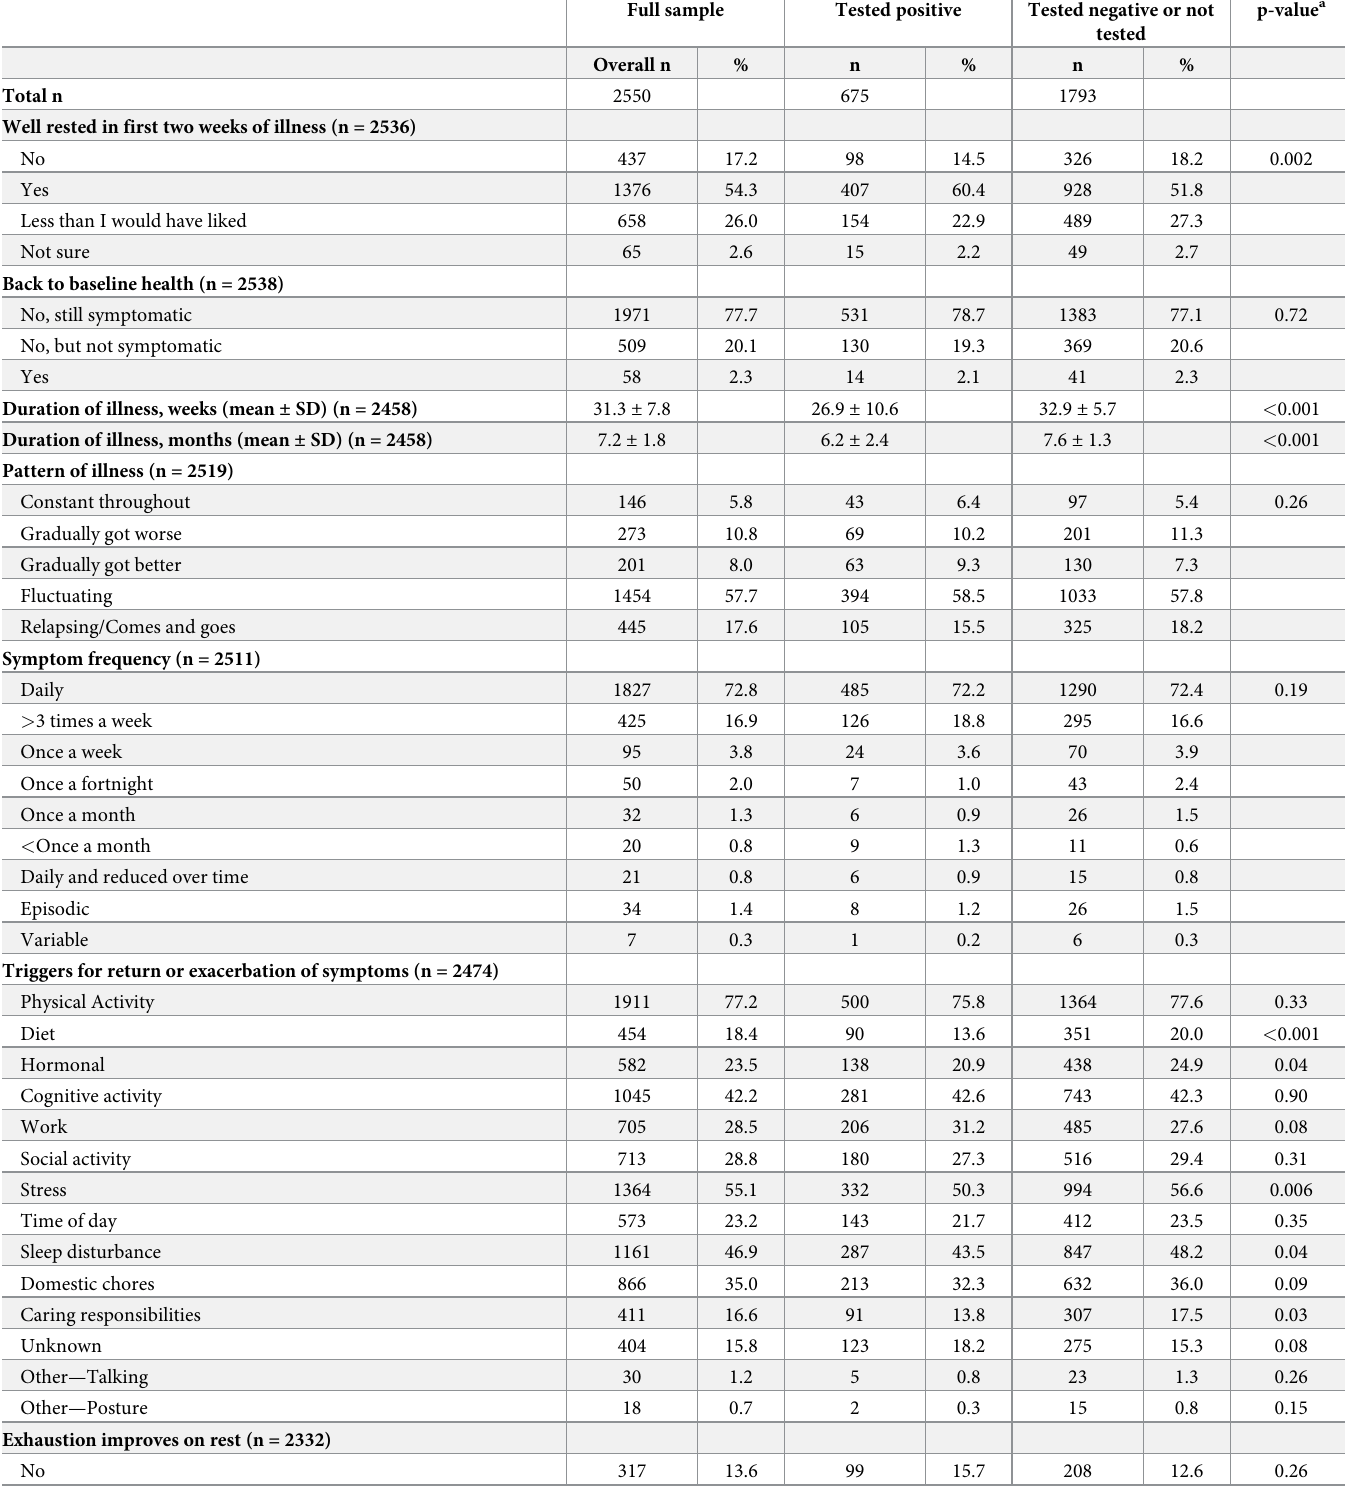
Table 4. Duration, pattern and triggers of